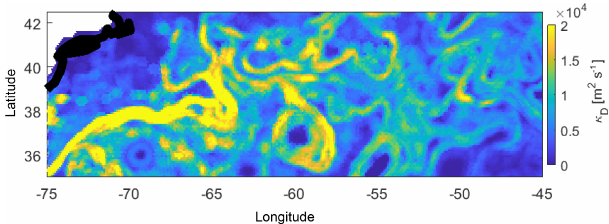
Figure 6. Dispersion-based diffusivity, κ D